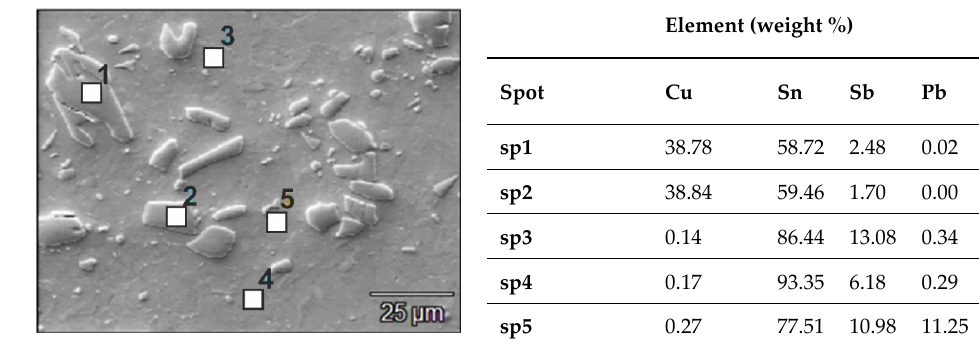
Figure 7. Microstructure of B89 alloy after FSP modification at 280 RPM and results of EDS chemical composition spot analysis; SEM.